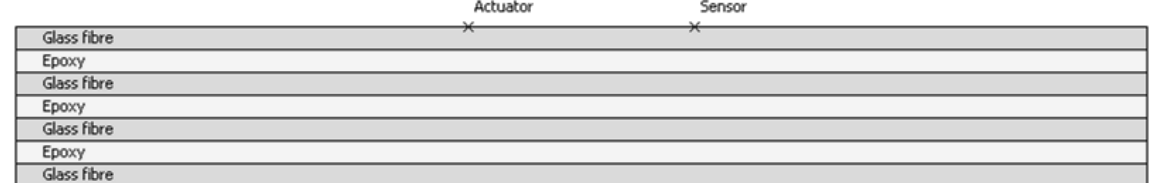
Fig. 6. The model of a composite plate used in the LISA simulation.